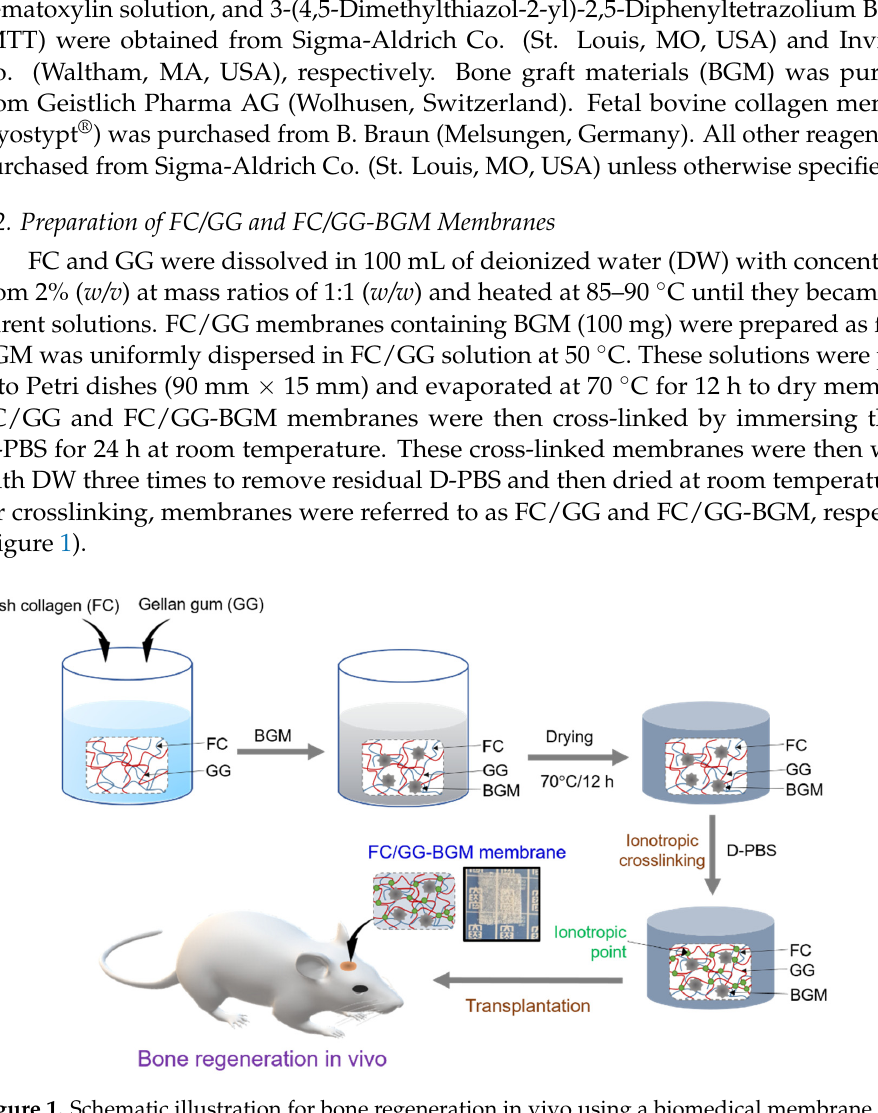
Figure 1. Schematic illustration for bone regeneration in vivo using a biomedical membrane made of fish collagen (FC)/gellan gum (GG) containing bone graft materials (BGM). fish collagen (FC)/gellan gum (GG) containing bone graft materials